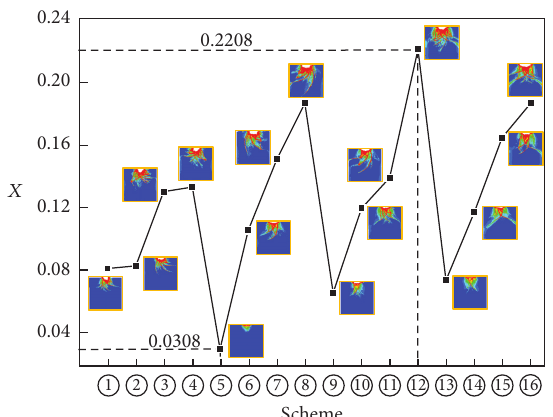
Figure 12: The distribution curve of the X -value under different nozzle parameter